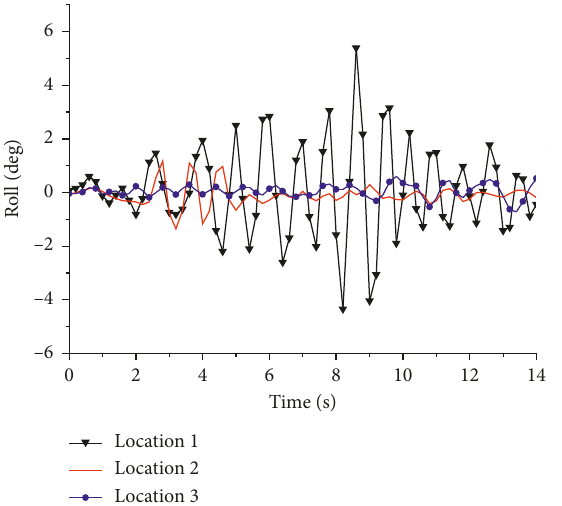
Figure 9: Ship’s roll-time curve at different navigation positions. Figure 10: Time-history curve of the ship’s roll angular velocity at different navigation